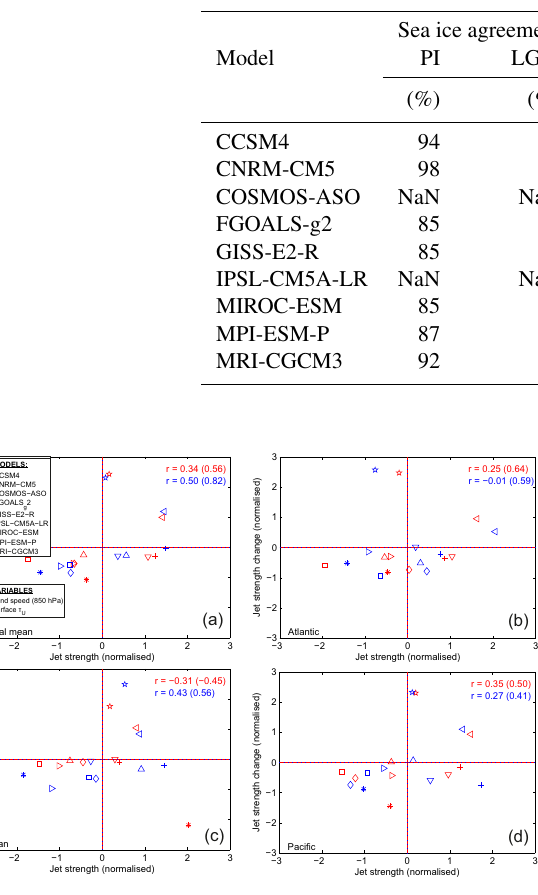
Figure 3. The state dependence of jet intensity (wind speed) changes. (a) Scatter plot of PI annual mean Southern Ocean jet strength versus LGM minus PI change in the CMIP5-PMIP3 mod- els. Zonal mean (a) , Atlantic sector (b) , Indian sector (c) , and Pa- cific sector (d) . Results are normalised by subtracting the mean of all models, and dividing through by the standard deviation of all models. Caption and results as Fig.